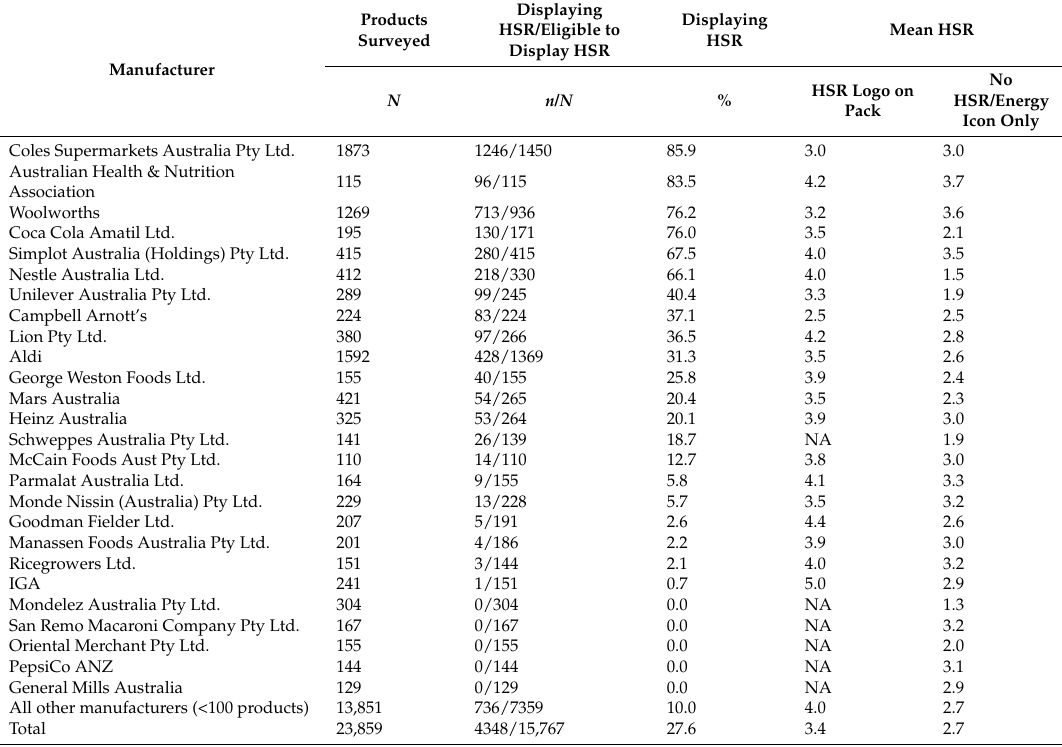
Table 2. HSR uptake by manufacturer, and mean HSR by manufacturer among products with a HSR logo on pack, and those either not displaying the HSR logo or carrying the energy icon only in the 2017 FoodSwitch Monitoring Dataset. Displaying Products Displaying HSR/Eligible to Surveyed Display HSR Manufacturer